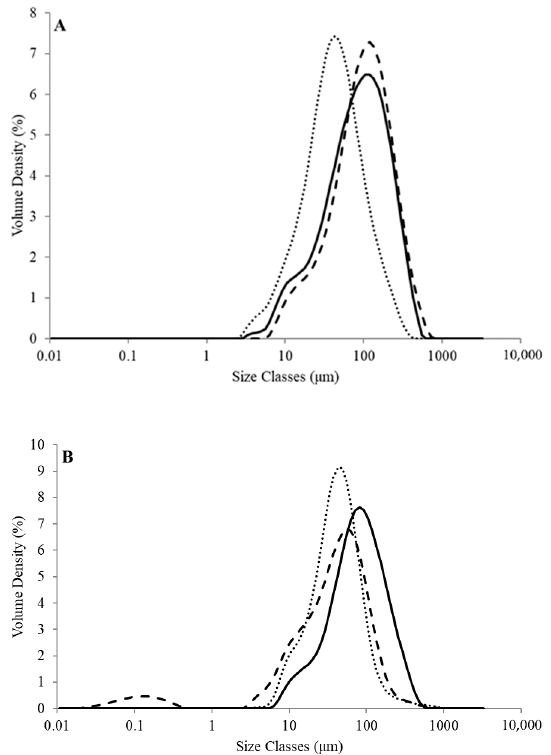
Figure 3. Particle size of soy protein isolate dispersions without ( A ) and with heat treatment ( B ) (90 °C × 20 min) at pH 6.9 ( ―― ), pH 9.0 ( ─ ─ ─ ) and pH 2.0 ( ‧‧‧‧ ).